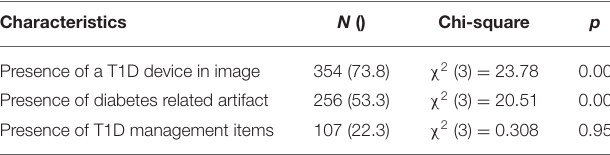
TABLE 5 | Correlation of T1D post characteristics with positive vs. negative sentiment. Characteristics